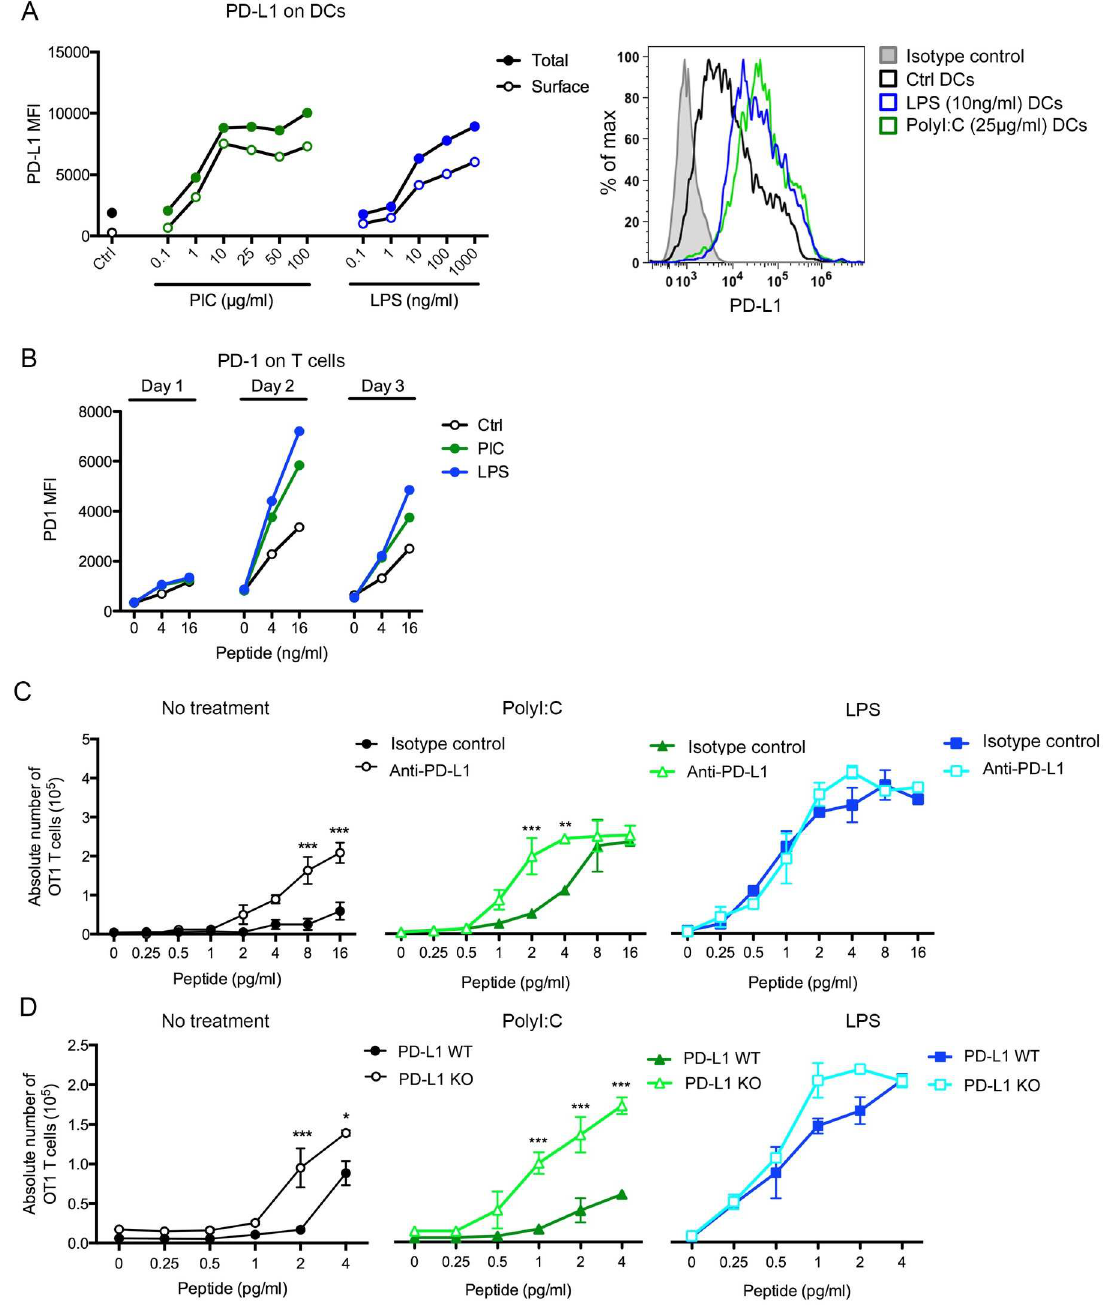
Fig 3. PolyI:C pre-treatment of DCs induces a PD-L1-dependent inhibition of CD8 + T cell responses. ( A ) Left: DCs treated with the different doses of TLR ligandfor 20 h were stained with an anti-PD-L1antibody with (total) or without permabilization (surface) and analysedby flow cytometry. Right: FACs profiles of PD-L1 expressionon DCs treated with the indicatedconcentrations of PolyI:C or LPS for 16 h (MFI of Isotype control: 1033 (only one isotype control is shown for clarity, isotypes on all DCs had similar values), Ctrl non-treatedDCs: 8504, LPS-pre-treated DCs: 36614, polyI:C pre-treatedDCs: 43123). ( B ) MFI of PD-1 on OT1 T cells co-cultured for 1, 2 or 3 days with nothing(ctrl), polyI:C (PIC, 25 μ g/ml) or LPS (10 ng/ ml)-treated DCs loadedwith 0, 4 or 16 pg/mL of SIINFEKL peptide. T cells were gated on their forward and side scatter profile. ( C ) DCs left untreated(ctrl, left) or treated for 20 h with polyI:C (25 μ g/mL, middle,green lines) or LPS (10 ng/ml), right, blue lines) were loadedwith different concentrations of the SIINFEKL peptide.They were then pre-incubated for 1 h with an anti- PD-L1 antibodyor an isotype control antibody(lighter lines) before incubation with OT1 T cells at a 1:1 ratio. 3 days later, the numbersof T cells in the well were enumeratedusing flow cytometry. ( D ) DCs from wild type mice (WT) or PD-L1 knockout mice (PD-L1 KO) were stimulatedor not with polyI:C (25 μ g/mL) or LPS (10 ng/ml), loadedwith the SIINFEKL